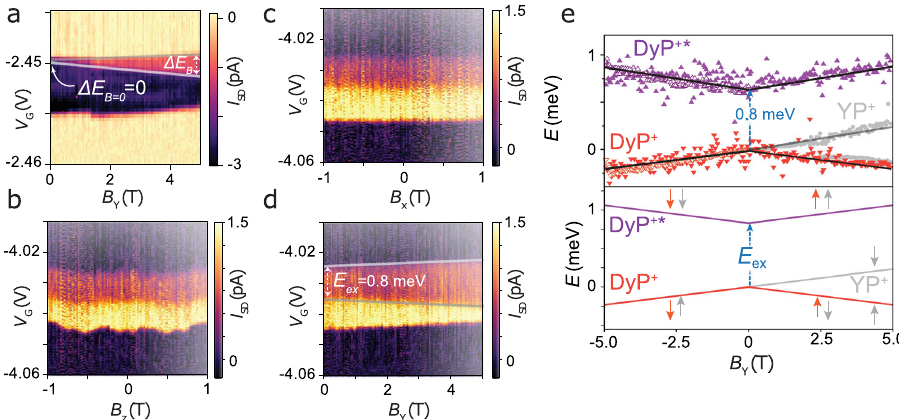
Fig. 4 Exchange splitting. a Splitting of the lowest energy peak for the YP device, on increasing B Y , acquired at V SD = – 1.5 mV. A spin doublet is visible (gray lines), without exchange. b Dependence of the ground state and excited state transition potentials for DyP + /DyP on increasing B z , acquired at V = 1.5 mV. c Dependence of ground state and excited state transition potentials for DyP + /DyP on increasing B SD d Dependence of ground state and excited state transition potentials for DyP + /DyP on increasing B y , acquired at V SD = 1.5 mV. e Upper panel shows a separation of the magnetic levels vs. B Y , for two DyP devices (triangles, full and open) and for the YP device (gray circles). Lines are fi ts to the data. Lower panel, expected evolution of the magnetic fi eld levels for DyP + (color) and YP + (gray). Dy(III) spins are orange and porphyrin ones gray. All data were acquired at 20